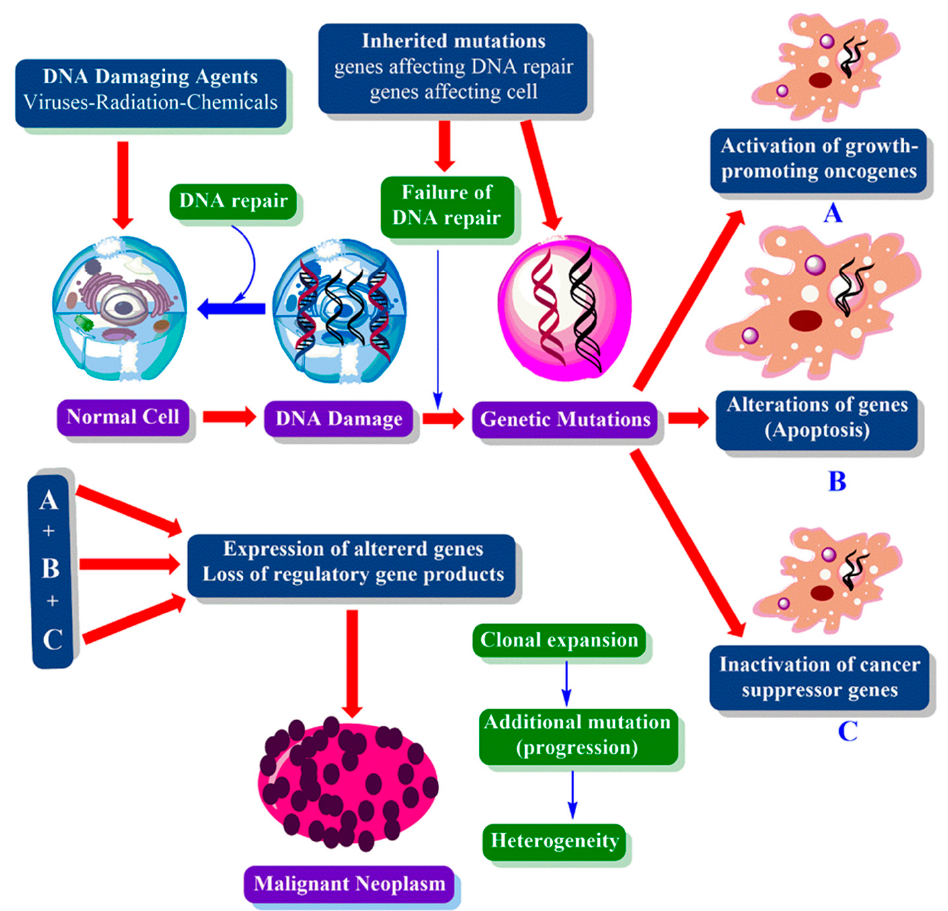
Figure 5. Schematic representation of cancer mechanism involving oncogenes (genes such as RAS, Erk and MYC), tumor suppressor genes (TP53 gene) and DNA repair genes.